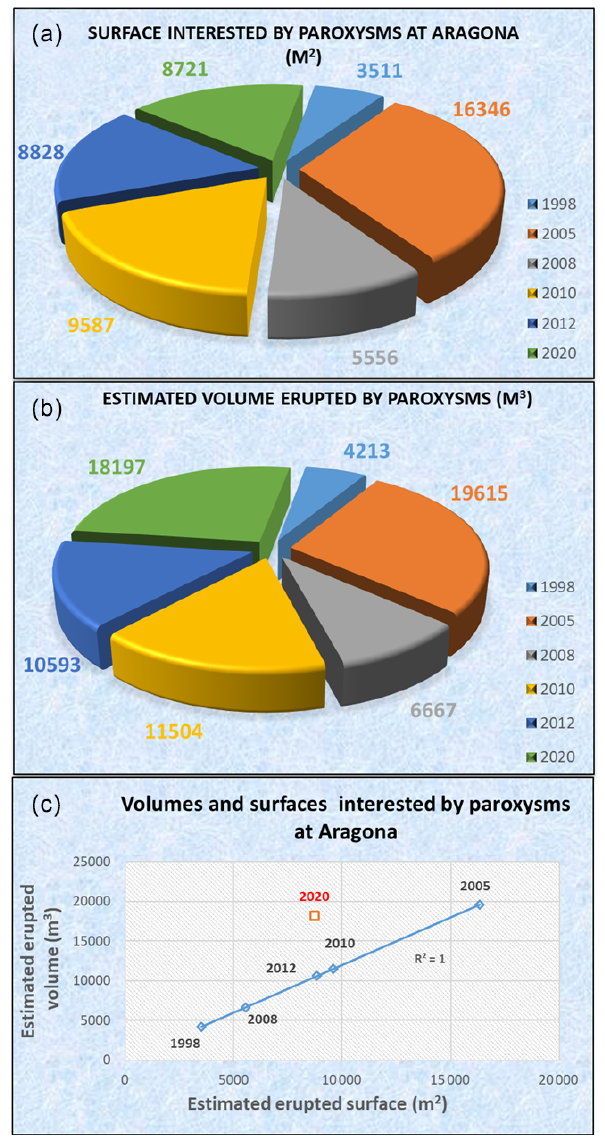
Figure 3. (a) Estimated volume and (b) interesting surfaces at Arag- ona mud volcanoes during paroxysmal events. (c) Correlation co- efficient for erupted volume and interesting surface for the 1998– 2012 events (Grassa et al., 2012, modified). Blue is the linear corre- lation with R 2 = 1. The red square represents the 2020